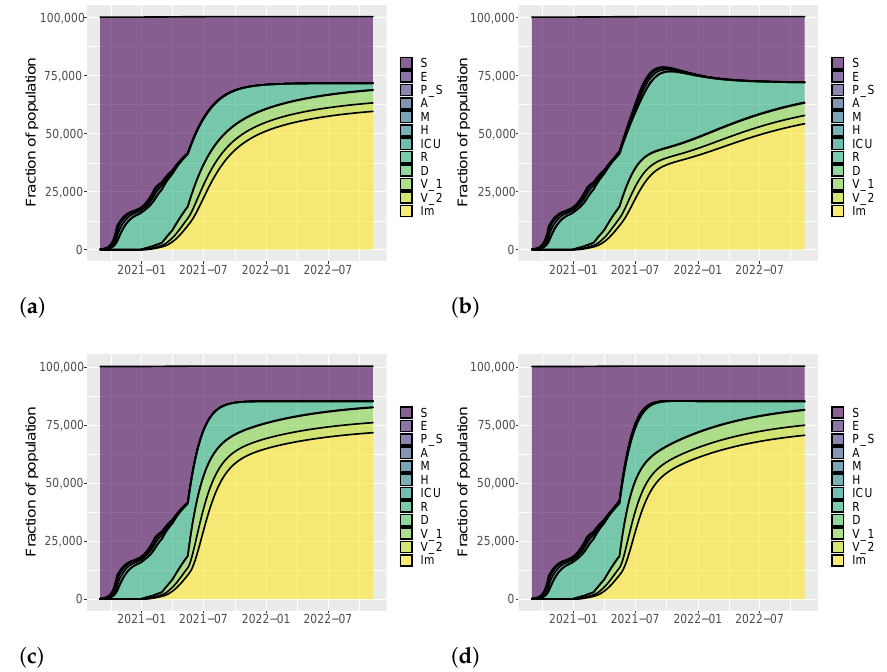
Figure 8. Area plots of model variables to compare the long-term evolution of the epidemic dynamics in Umbria. ( a ) 8000 first doses every day and low values for b e and b 0 (Low/Low). ( b ) 8000 first doses every day and high values for b e and b 0 (High/Low). ( c ) 18,000 first doses every day and low values for b e and b 0 (High/Low). ( d ) 18,000 first doses every day and high values for b e and b 0